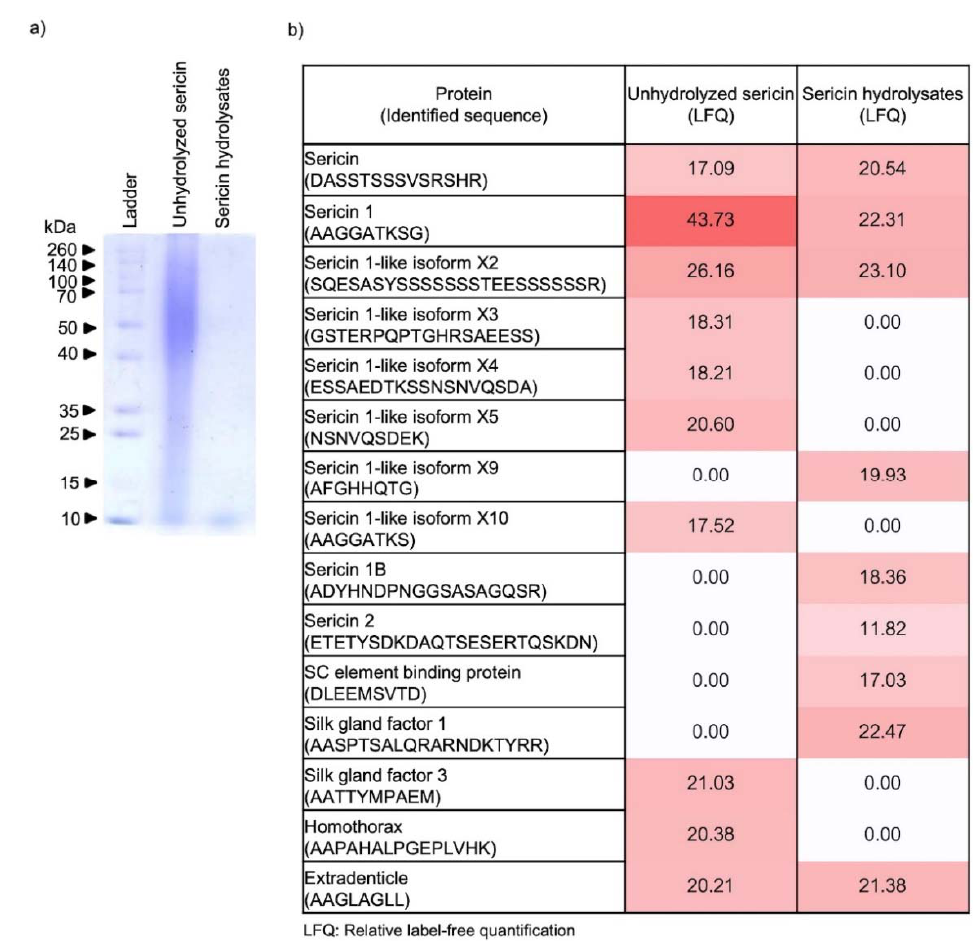
Figure 1. Peptide constituents in sericin hydrolysates modified by Alcalase ® . ( a ) The wide range of peptide distribution from 10 to 260 kDa was demonstrated in unmodified sericin via SDS-PAGE analysis while only peptide at ~10 kDa was contained in sericin hydrolysates prepared using Alcalase ® . ( b ) Peptidomic analysis revealed the alteration of both type and ratio of peptide constituents in sericin after enzymatic modification by Alcalase ® . The level of peptides in each sample were expressed as log2 value.